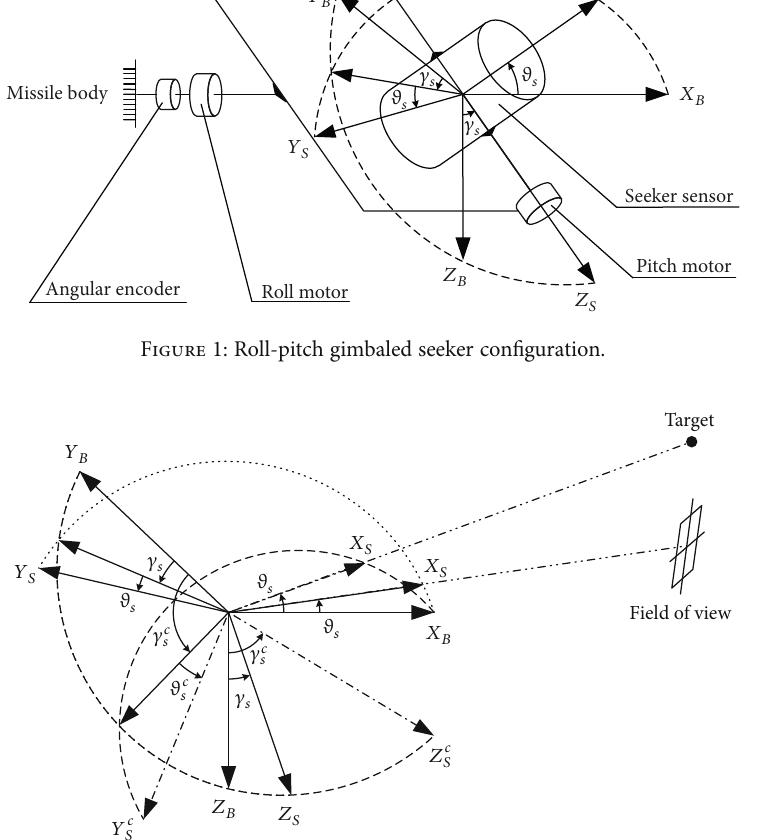
and ϑ c denote the desired frame angles while γ s s